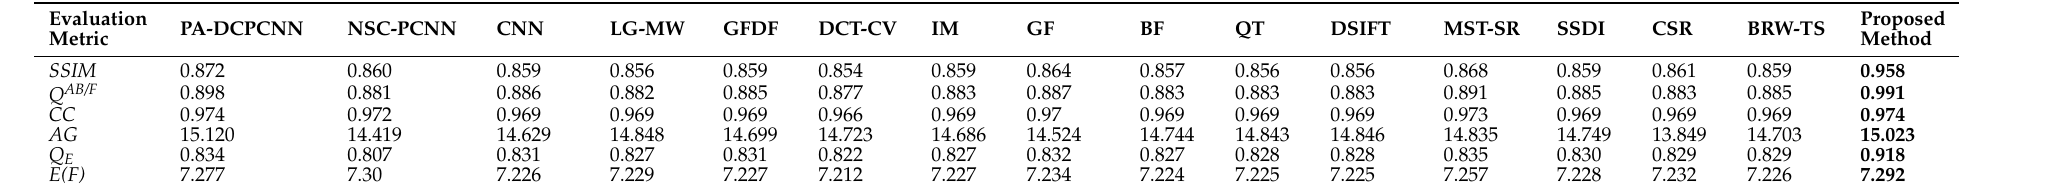
Figure 18. The multi-focus image sets in Figure 16 represent the fusion outcomes of the proposed technique. Table 38. Comparative Analysis of quantitative measures (average value)